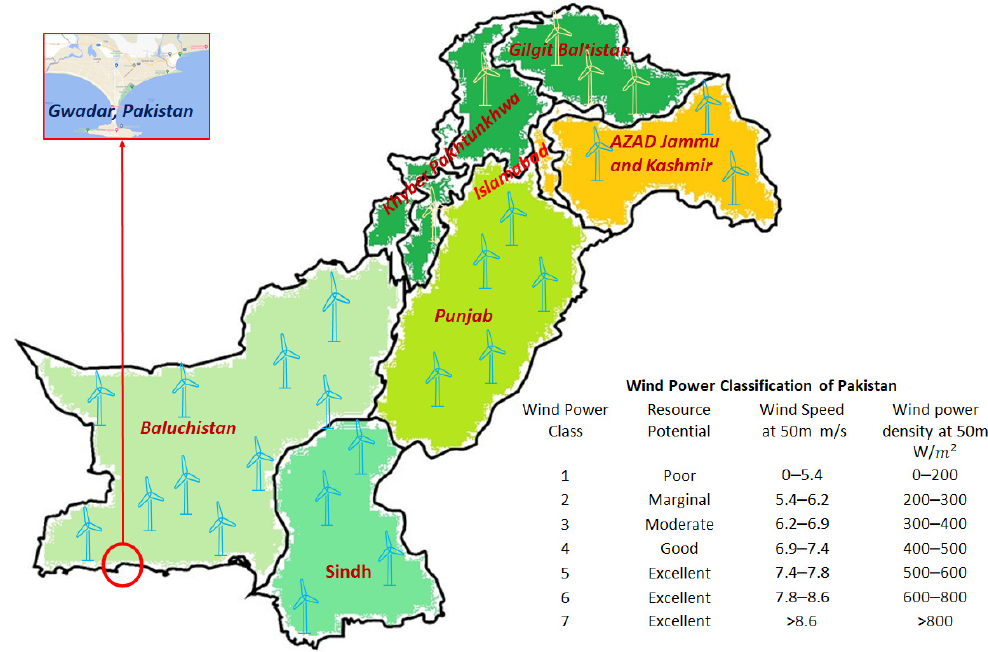
Figure 8. Geographical map of the wind power classification at a 50 m height in different areas in Pakistan [43].